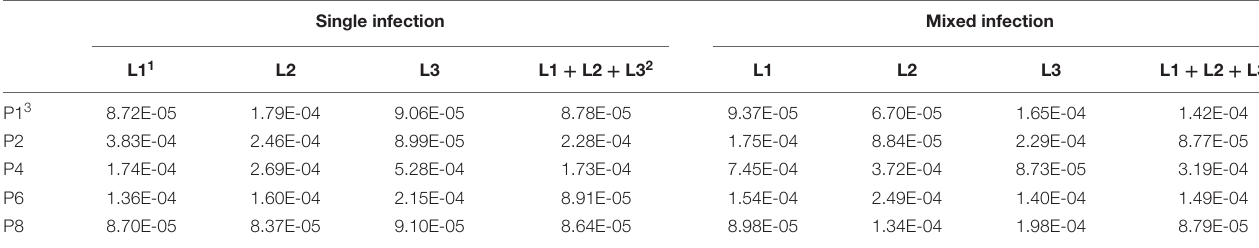
TABLE 2 | PepMV-EU nucleotide diversity ( π ) along passages. Single infection Mixed infection